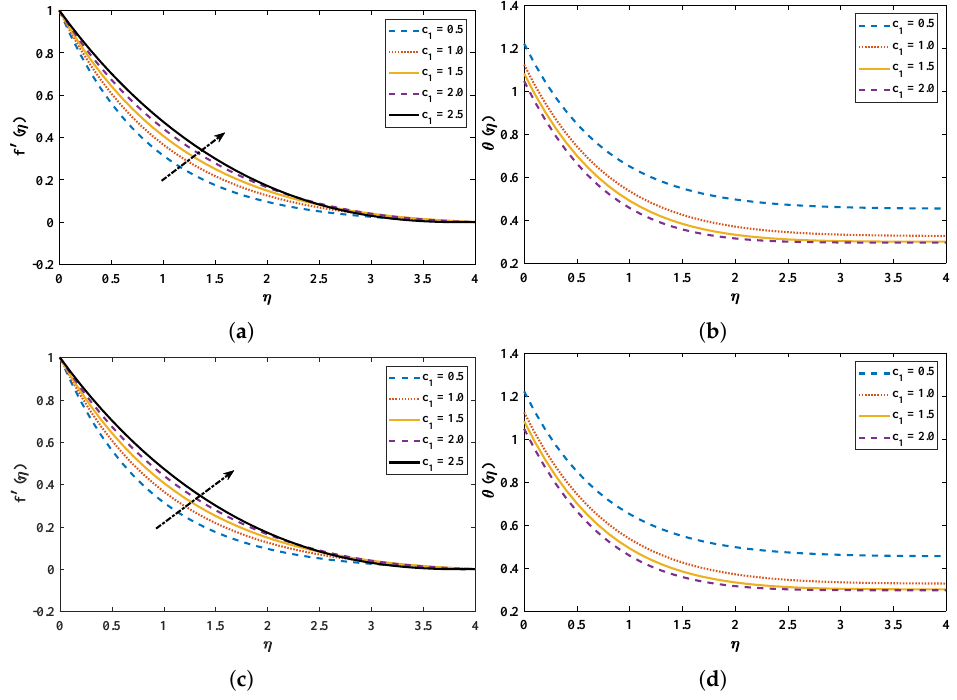
Figure 11. Graphical study of the influences of variations in micropolar material constants on the velocity and temperature of the fluid: ( a , b ) with isothermal boundary conditions and ( c , d ) with isoflux boundary